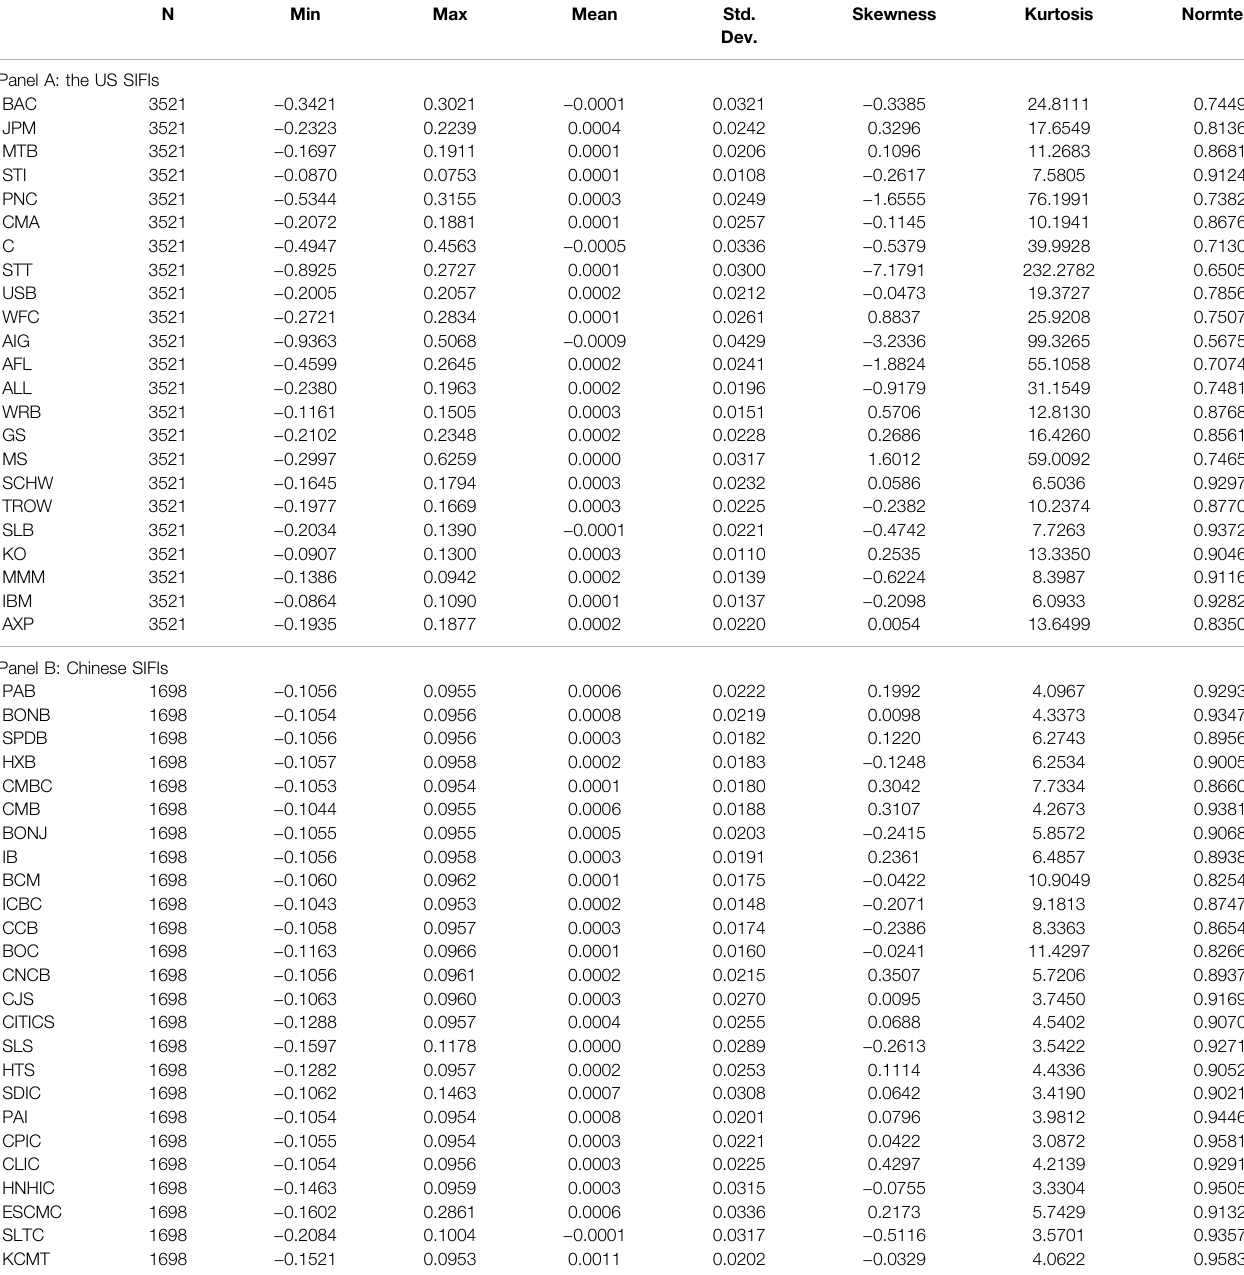
TABLE 3 | Descriptive statistics of 23 US SIFIs and 25 Chinese SIFIs. N Min Max Mean Std.